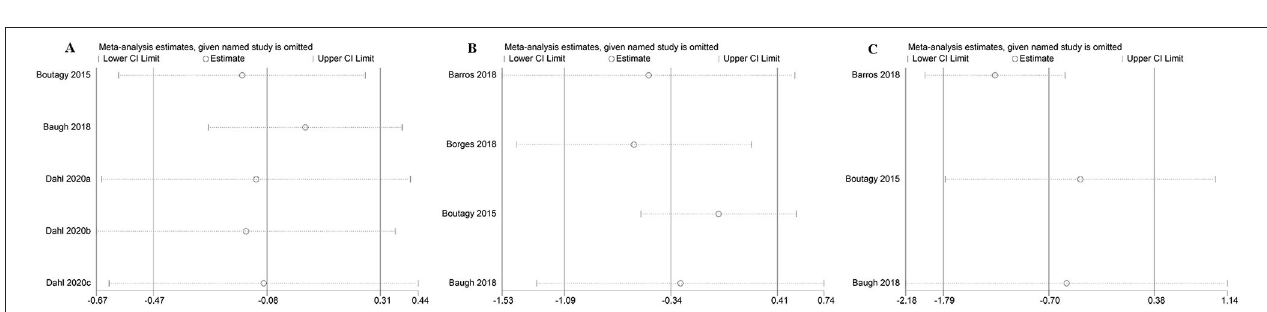
FIGURE 15 | The sensitivity analysis of the study. (A) The sensitivity analysis of microbiota-driven therapy on circulating choline level; (B) The sensitivity analysis of microbiota-driven therapy on circulating betaine aldehyde level; (C) The sensitivity analysis of microbiota-driven therapy on circulating L-carnitine